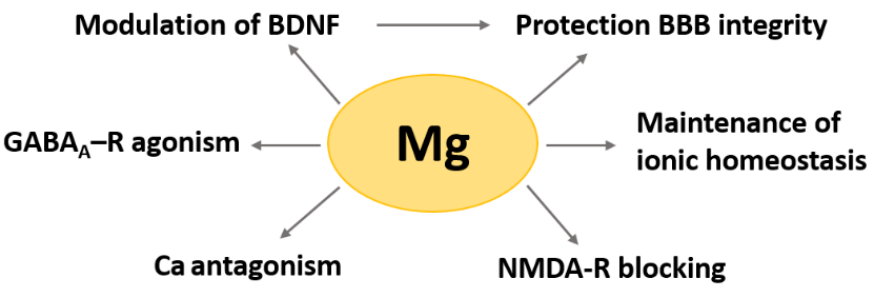
Figure 1. The role of magnesium in the brain. Magnesium in the brain plays a fundamental role in the modulation of different pathways.